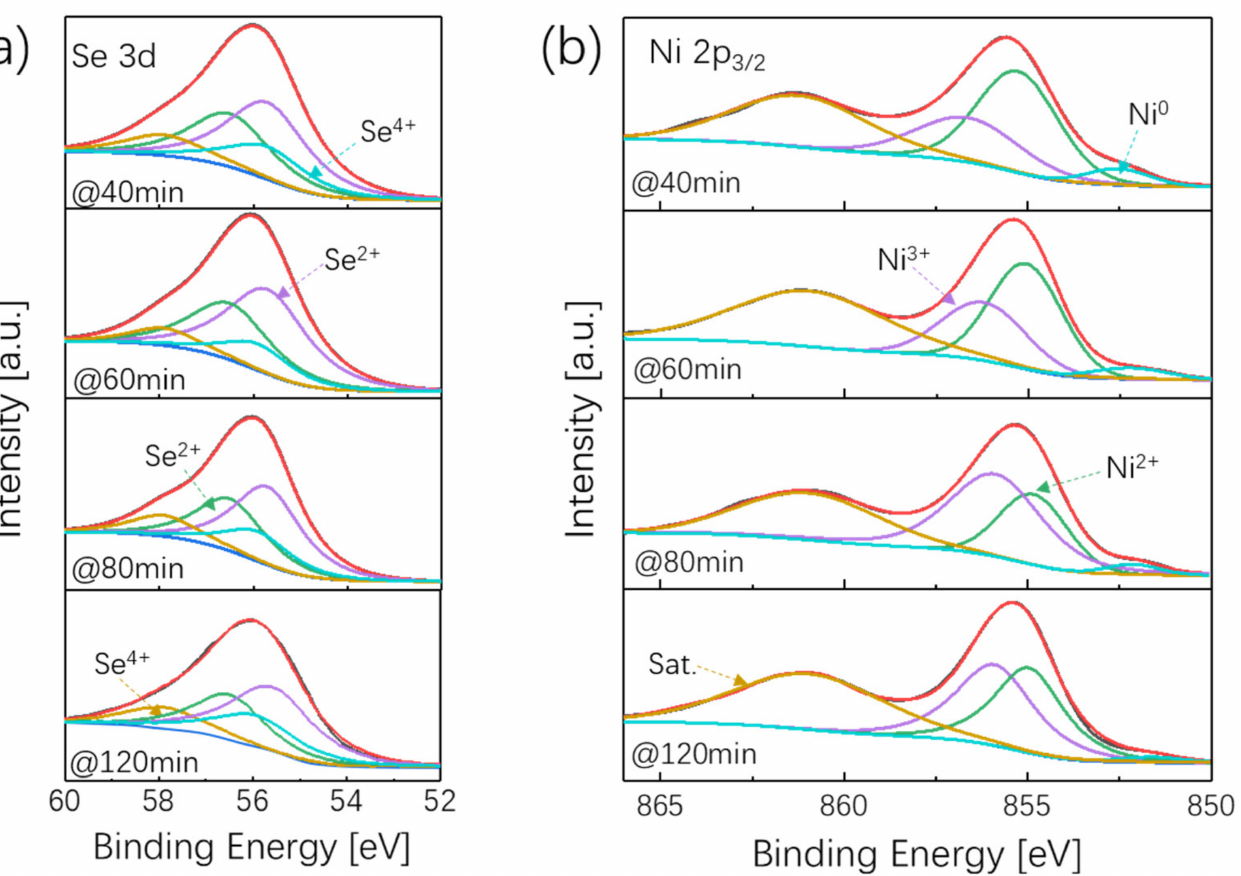
Figure 2. High-resolution XPS spectra of NixSey with different aging times. ( a ) Se 3d; ( b ) N